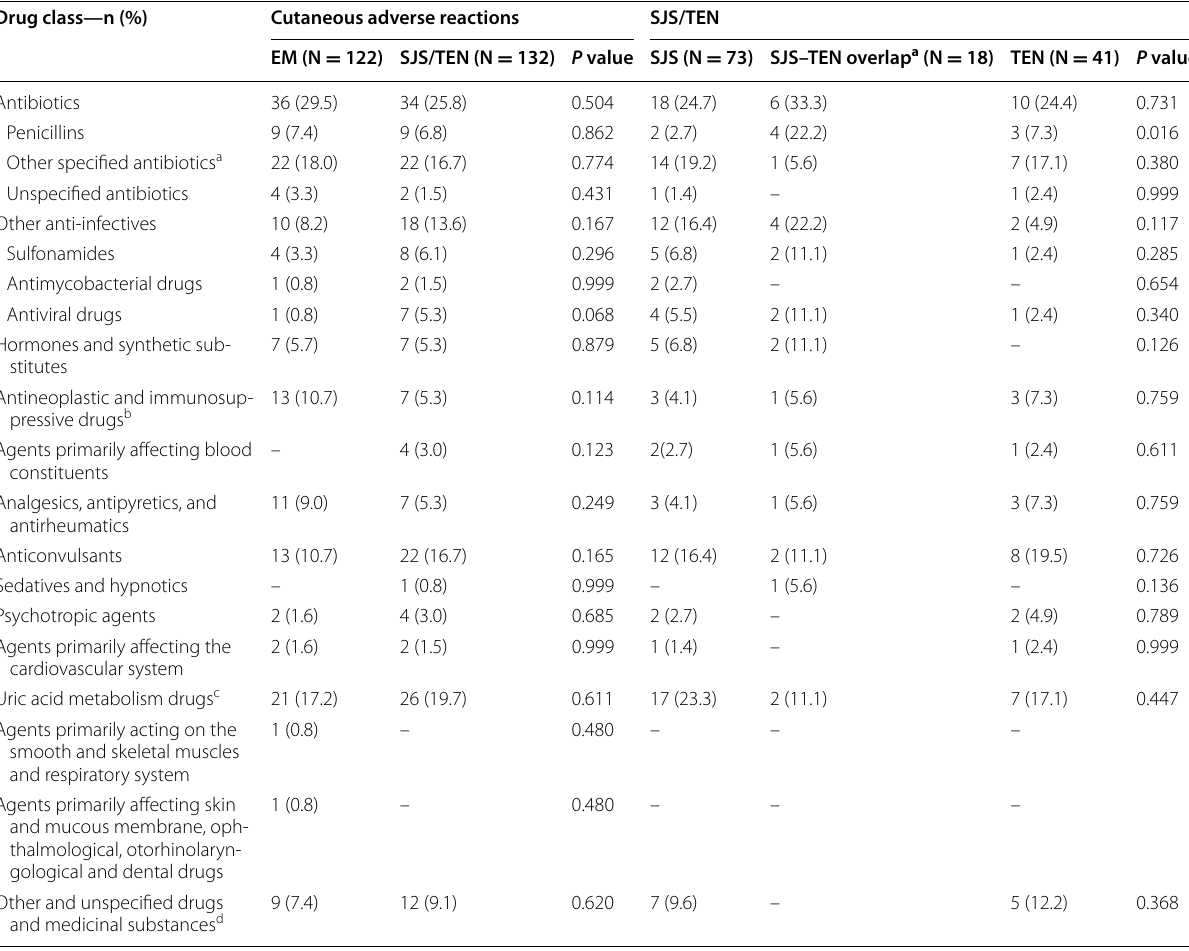
Table 3 Drug classes deemed responsible for the cutaneous adverse reactions occurred in the context of hospitalisations with an associated diagnosis of erythema multiforme (EM) or Stevens–Johnson syndrome/toxic epidermal necrolysis (SJS/TEN); Mainland Portugal, 2009–2014 ( n 254 =